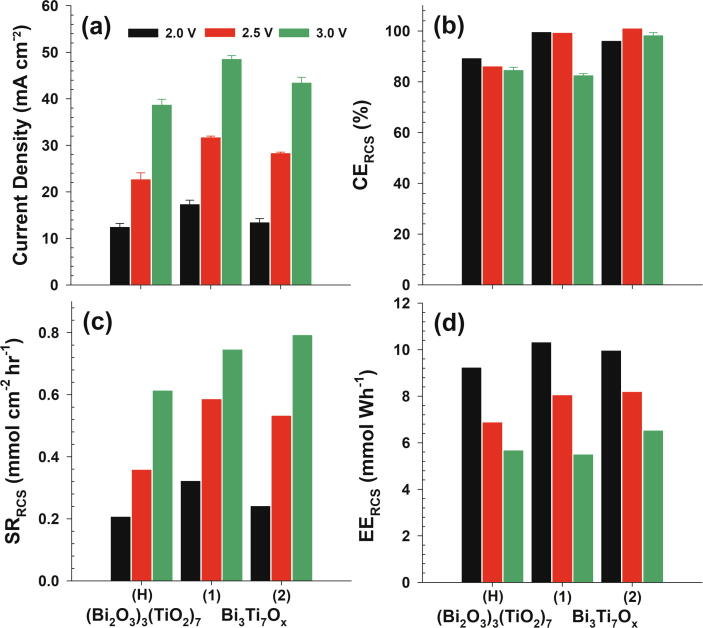
(a) Current density, (b) current efficiency, (c) specific rate and (d) energy efficiency of reactive chlorine species generation during potentiostatic electrolysis of 50 mM NaCl solutions (pH 7) with IrTaOy/(Bi3Ti7Ox-1, 2) heterojunction anodes; cathode: stainless steel, geometric surface area: 3 × 2 cm2, applied anodic potential: 2.0, 2.5, and 3.0 V NHE. Data for IrTaOy/(Bi2O3)3(TiO2)7-H anode are shown as references.